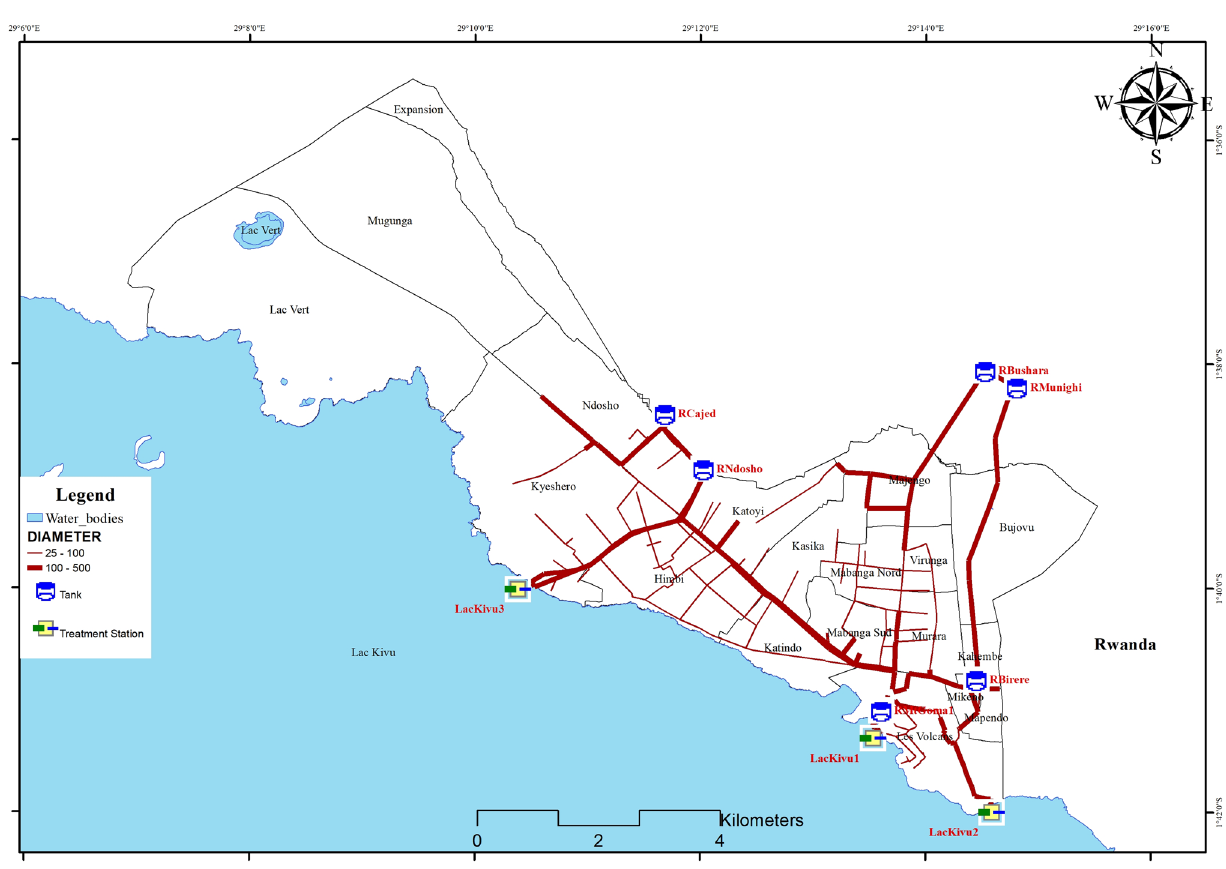
Fig. 2 Water supply network of the Goma